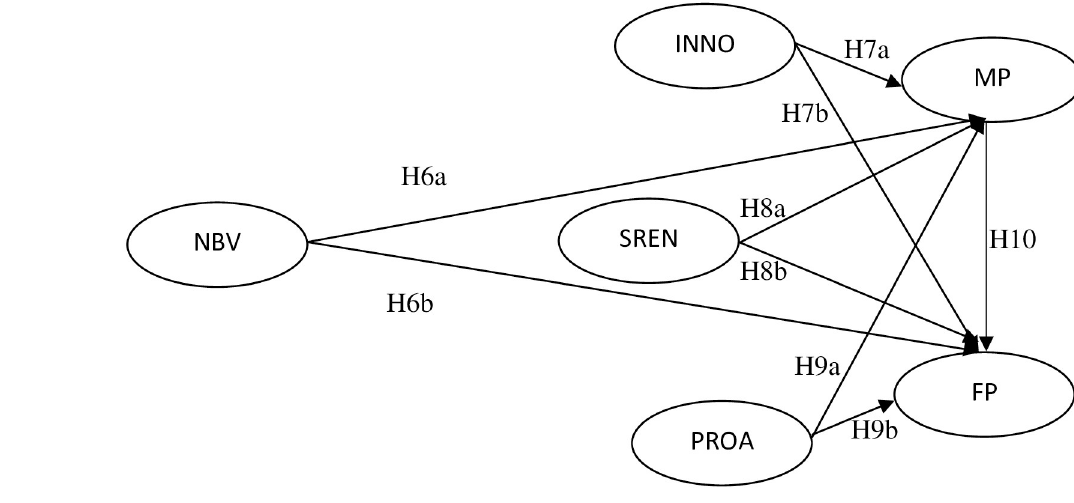
Fig 3. Conceptual model, Stage III. NBV = New Business Venturing, INNO = Innovation, PROA = Proactiveness, SREN = Self- renewal, FP = Financial Performance, MP = Market Performance.